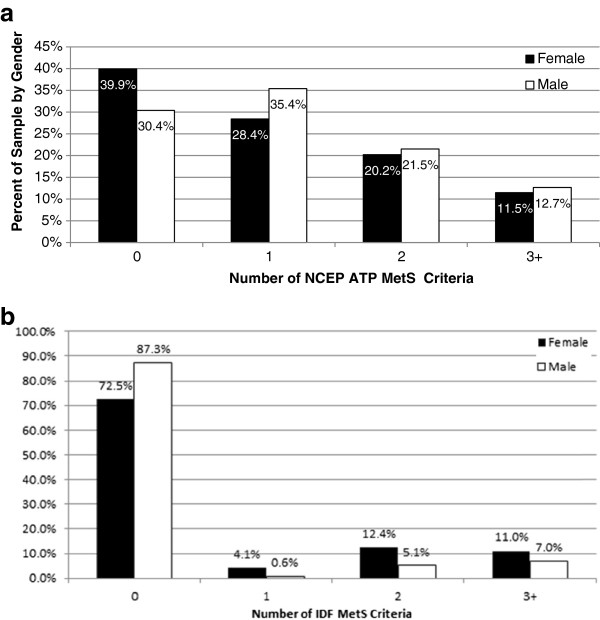
(a) Prevalence of NCEP ATP MetS criteria by gender. Data analyzed using Crosstabs Procedure, Pearson Chi-Square test for significance, non-Parametric Independent t-test. Female n=218; Male n=158. (b) Prevalence of IDF MetS criteria by gender. Data analyzed using Crosstabs Procedure, Pearson Chi-Square test for significance, non-Parametric Independent t-test. Female n=218; Male n=158.